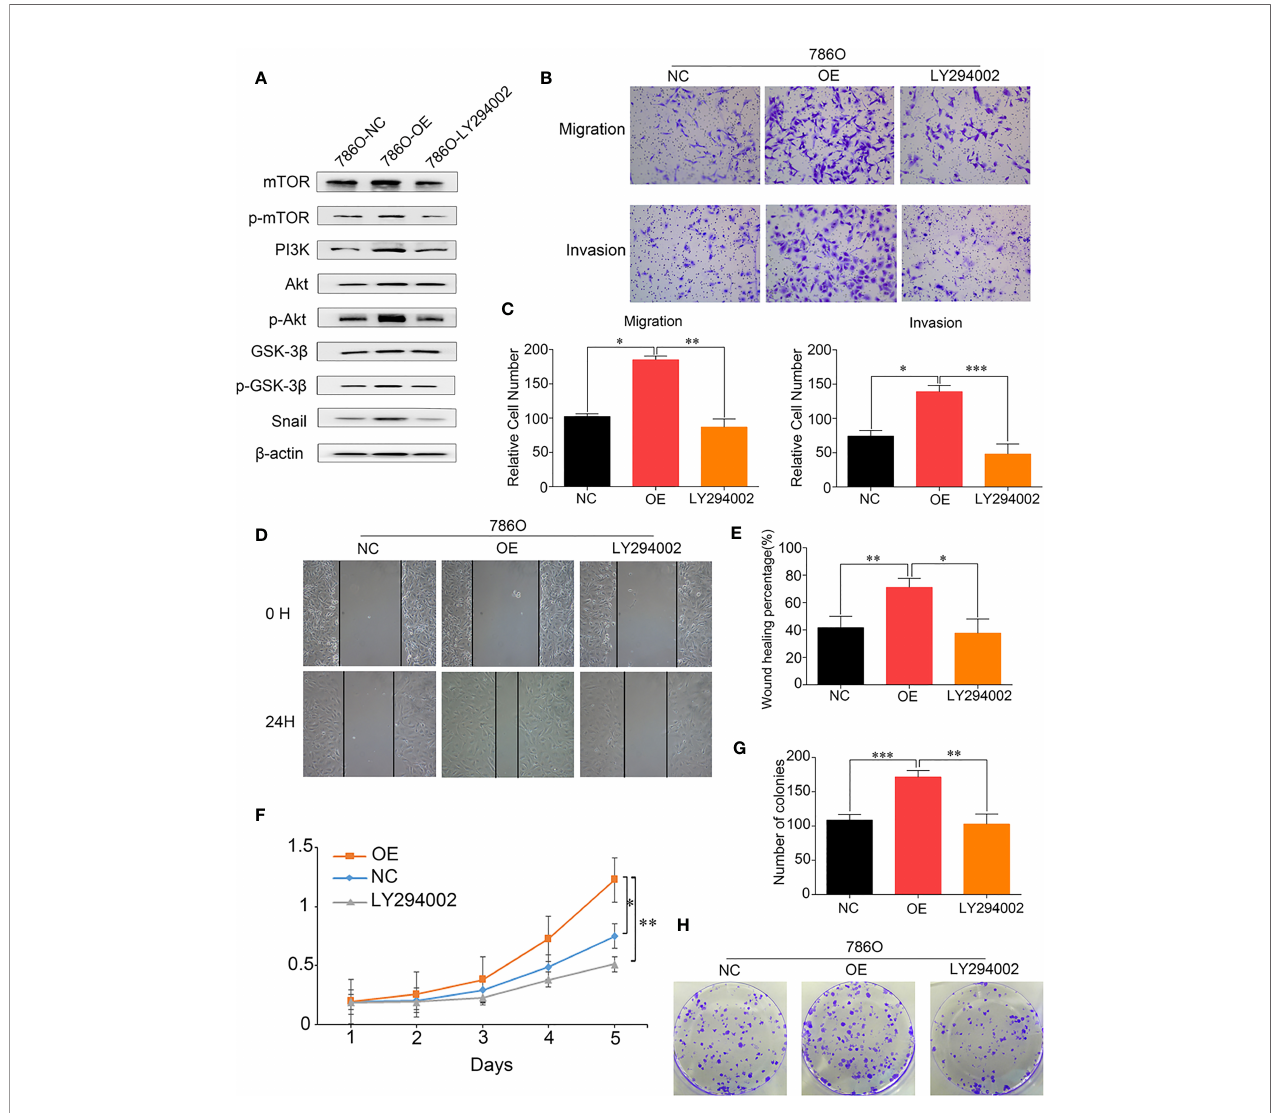
FIGURE 7 | DUXAP9 promoted renal cancer cells invasion, migration and proliferation via Akt pathway activation. (A) Western blots were performed to evaluate the key Akt pathway proteins levels after overexpression of DUXAP9 treated with or without LY294002. (B, C) 786O cells with DUXAP9 overexpression were treated with or without LY294002 and measured through the Transwell chamber without/with Matrigel. (D, E) 786O cells with DUXAP9 overexpression were treated with or without LY294002 and subjected to wound ‐ healing assays. (F) 786O cells with DUXAP9 overexpression were treated with or without LY294002 and subjected to CCK-8 assays. (G, H) 786O cells with DUXAP9 overexpression were treated with or without LY294002 and subjected to colony formation assays. Data represent mean ± SD from three independent experiments. OE, DUXAP9 overexpression; NC, overexpression negative control; CCK-8, cell counting kit-8; *P < 0.05; **P < 0.01; ***P <